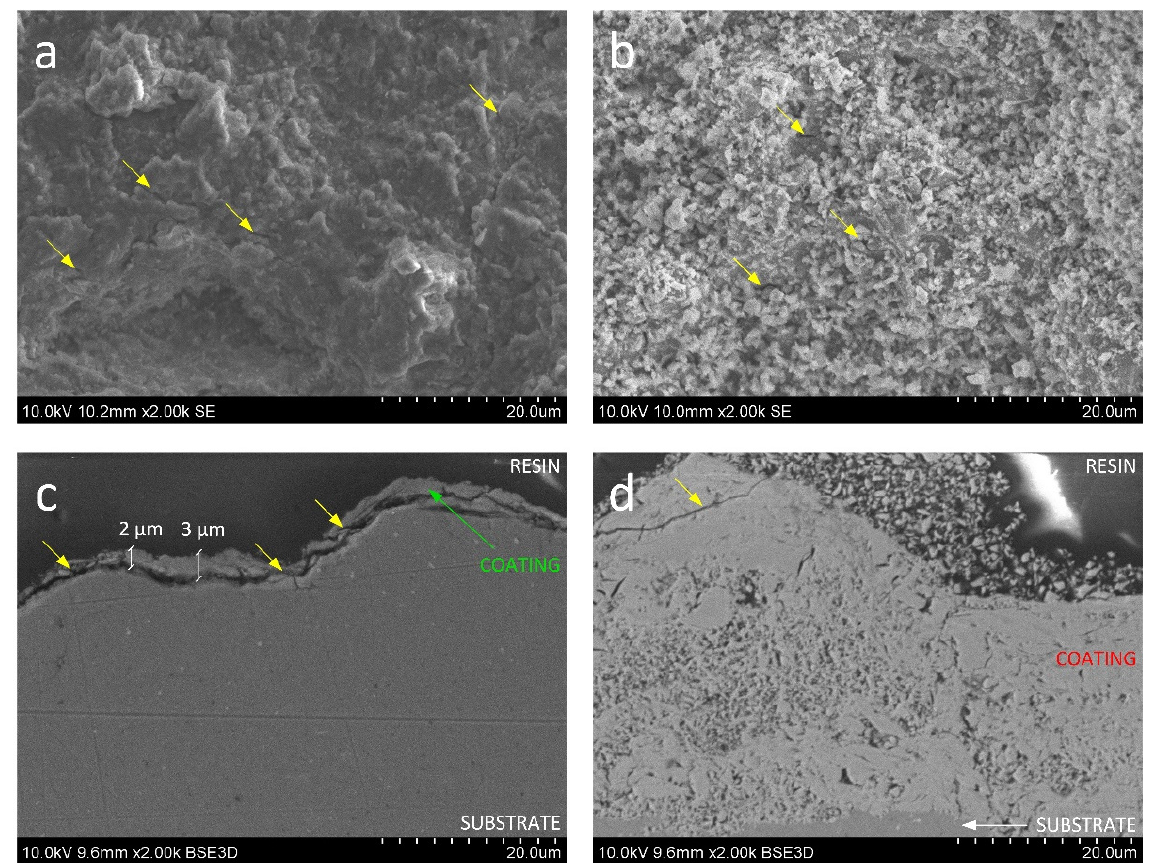
Figure 4. SEM micrograph of ( a , b ) topography and ( c , d ) cross section of ( a , c ) 200 and ( b , d ) 600 coatings. Detailed view.